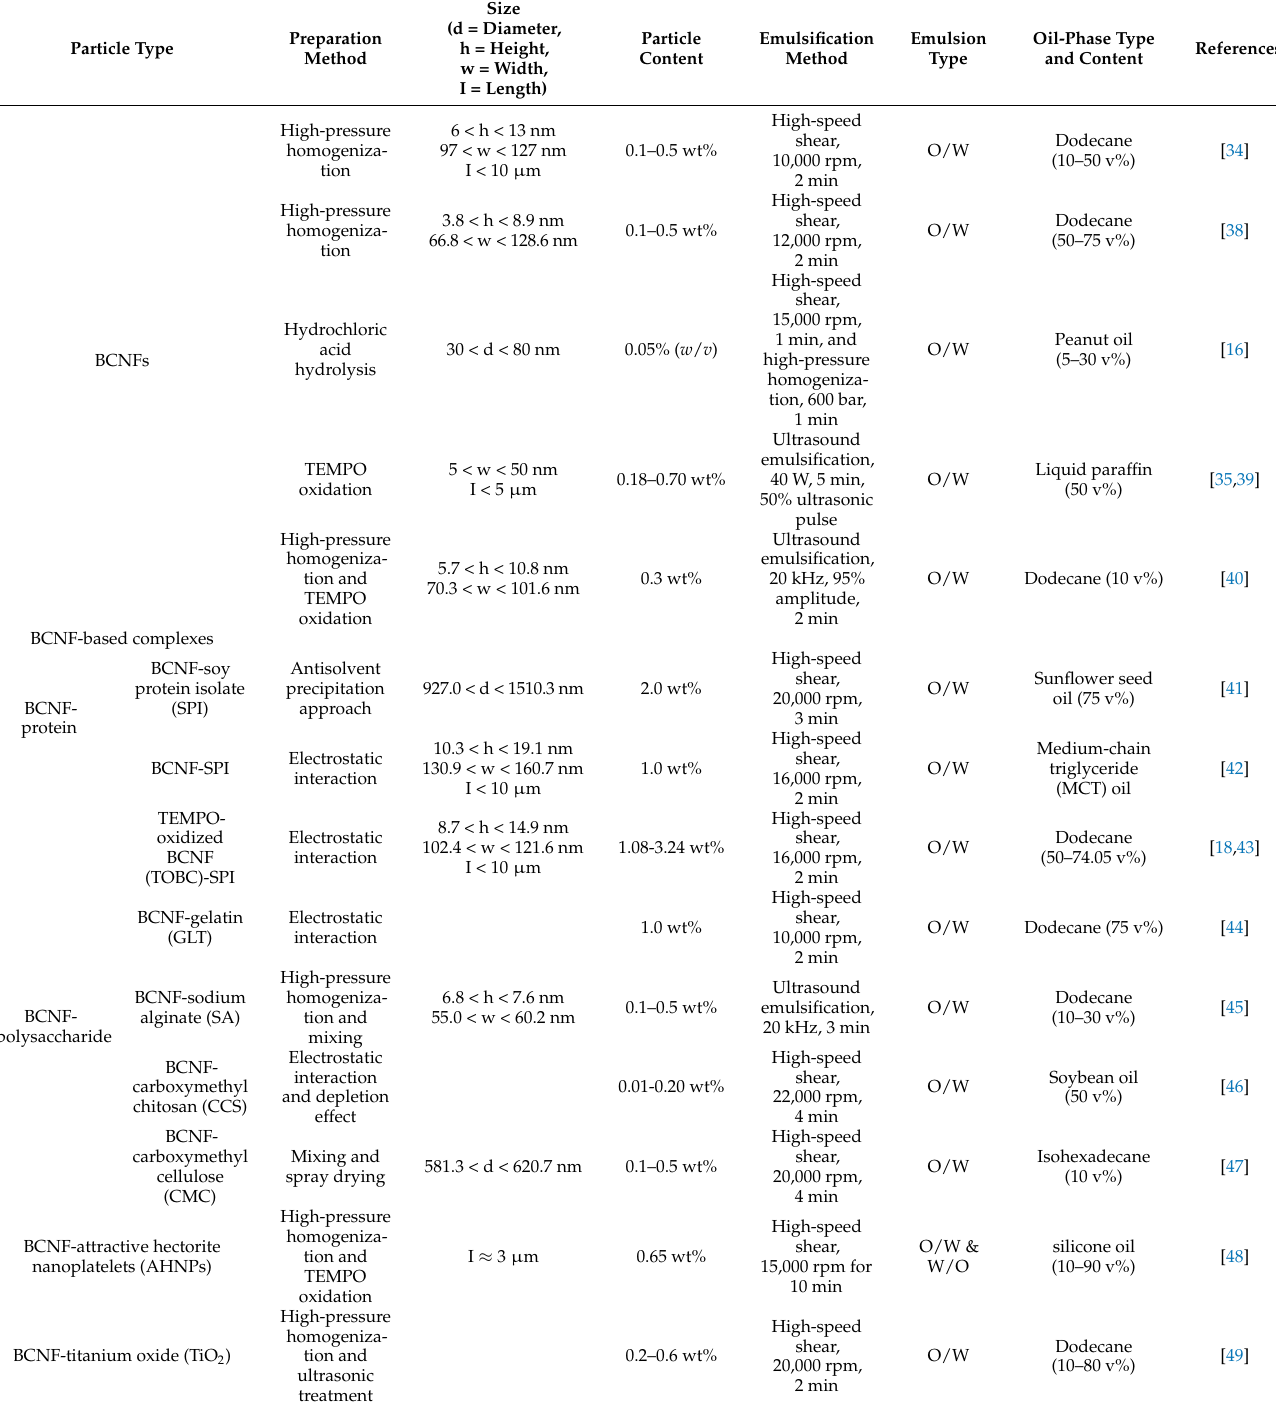
Table 1. Summary of the preparation of Pickering emulsions using different BCNF-based colloidal